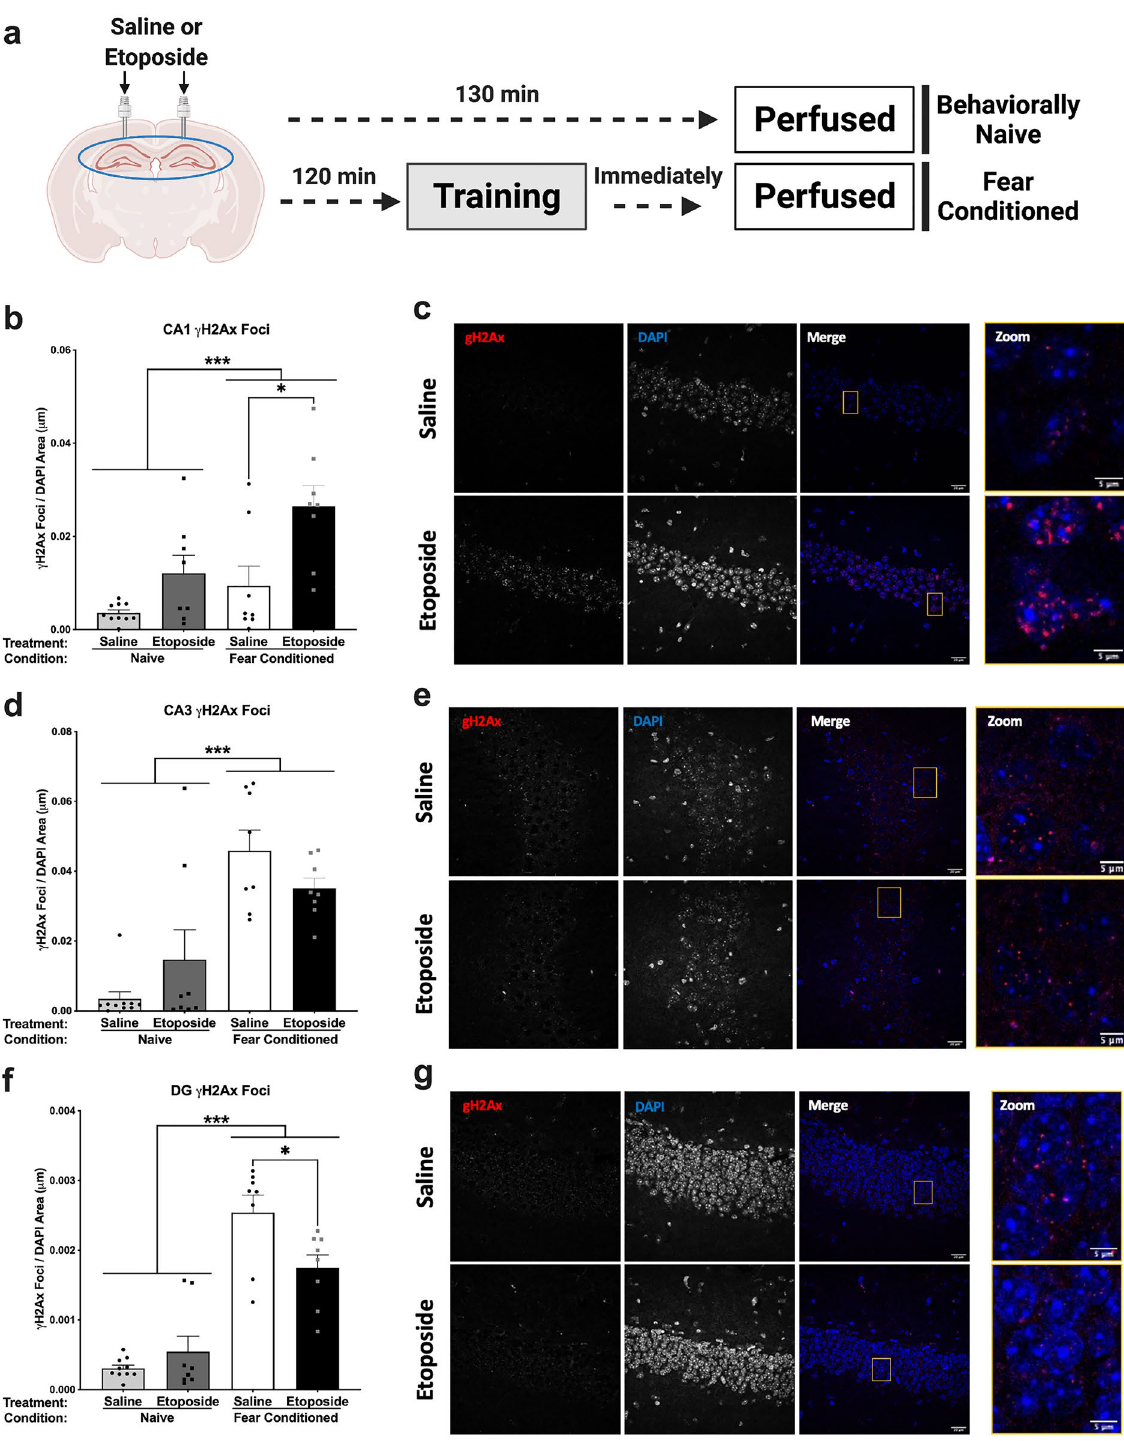
Figure 1. Analysis of γH2Ax in the hippocampus following infusions of saline or etoposide and fear conditioning. ( a ) Schematic of the experimental timeline ( n = 4–5/behavioral group/treatment). ( b ) γH2Ax foci in CA1. Fear conditioning significantly increased the number of γH2Ax foci ( F (1,30) = 12.599, p = 0.001). Etoposide infusions significantly increased the number of γH2Ax foci ( F (1,30) = 20.587, p < 0.001). ( c ) Representative images of γH2Ax staining in the CA1 from fear conditioned mice. The far-right panel is zoomed in on the yellow box in the “merge” image. ( d ) γH2Ax foci in CA3. Fear conditioning significantly increased γH2Ax foci ( F (1,30) = 53.260, p < 0.001). Etoposide infusions did not change the number of γH2Ax foci ( F (1,30) = 0.003, p = 0.995). There was a significant interaction between behavior and treatment groups ( F (1,30) = 4.689, p = 0.038). ( e ) Representative images of γH2Ax staining in the CA3. ( f ) γH2Ax foci in the DG. Fear conditioning significantly increased γH2Ax foci ( F (1,30) = 128.782, p < 0.001). There was a significant interaction between behavior condition and treatment ( F (1,30) = 9.203, p = 0.005), where etoposide infusions significantly decreased the number of γH2Ax foci in the fear conditioned group ( p < 0.05) but increased it in the naïve group. ( g ) Representative images of γH2Ax staining in the DG. Data are presented as total number of foci normalized to area of DAPI (mm) ± SEM. * p <